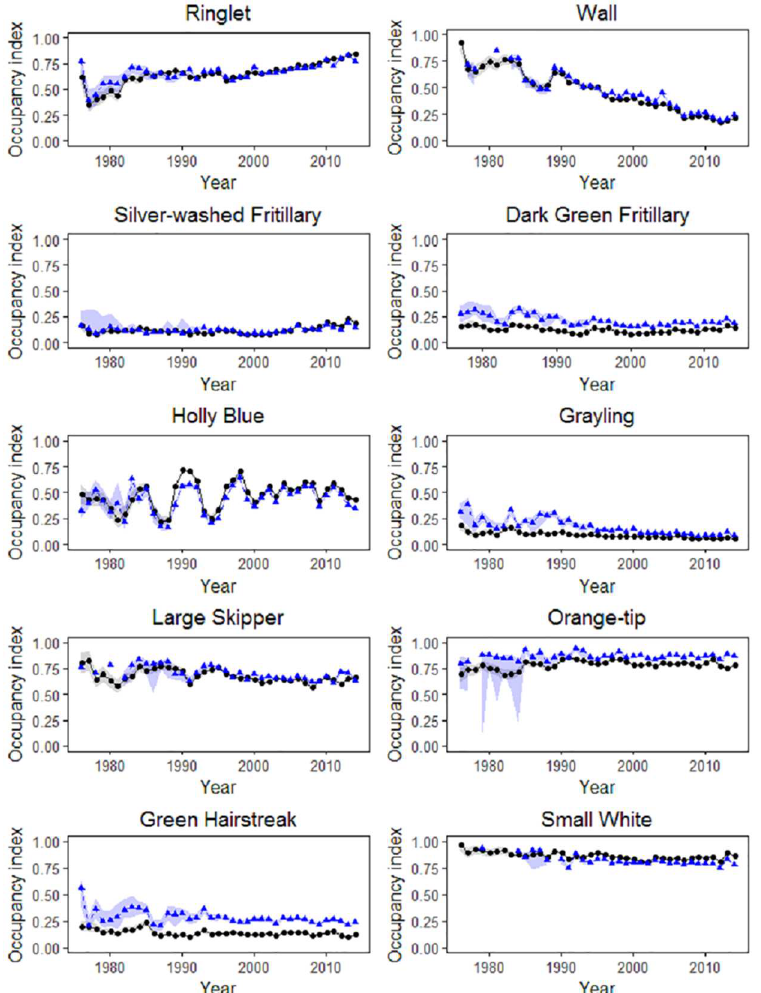
Fig 3. Index Comparison for models B (black, circles) and C (blue, triangles). The 95% confidence bandsfollow directly from the MCMC of the Bayesiananalysisand from an approximate bootstrap approach in the classical case. In model C, detectionprobabilityhas two covariates,the seasonalcovariate and list length, and the data are restricted in